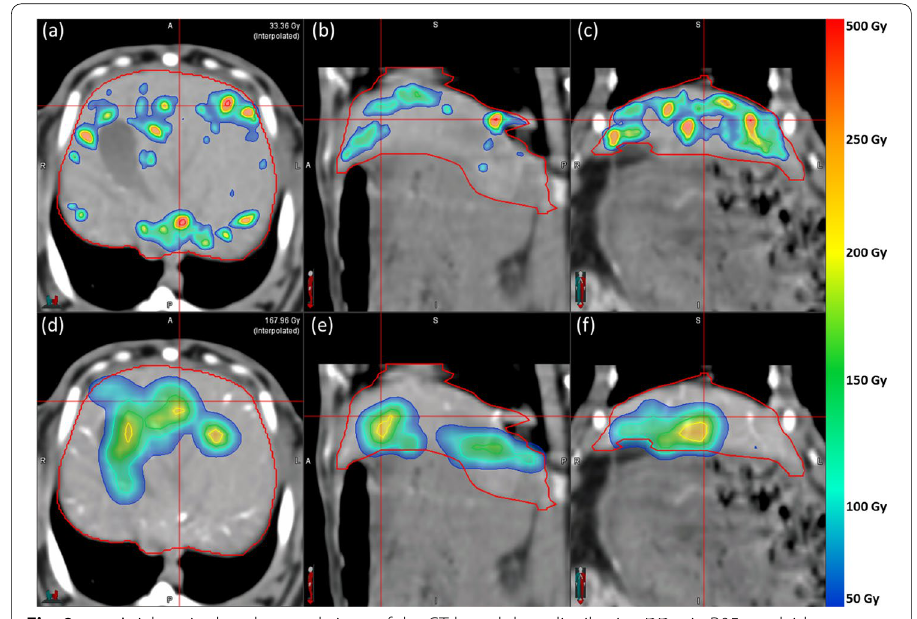
Fig. 9 a – c Axial, sagittal, and coronal views of the CT-based dose distribution DD CT in R05 overlaid on an axial CT [ 100 to 200 HU]. d–f Axial, sagittal, and coronal views of the PET-based dose distribution DD PET in − R05 overlaid on an axial CT [